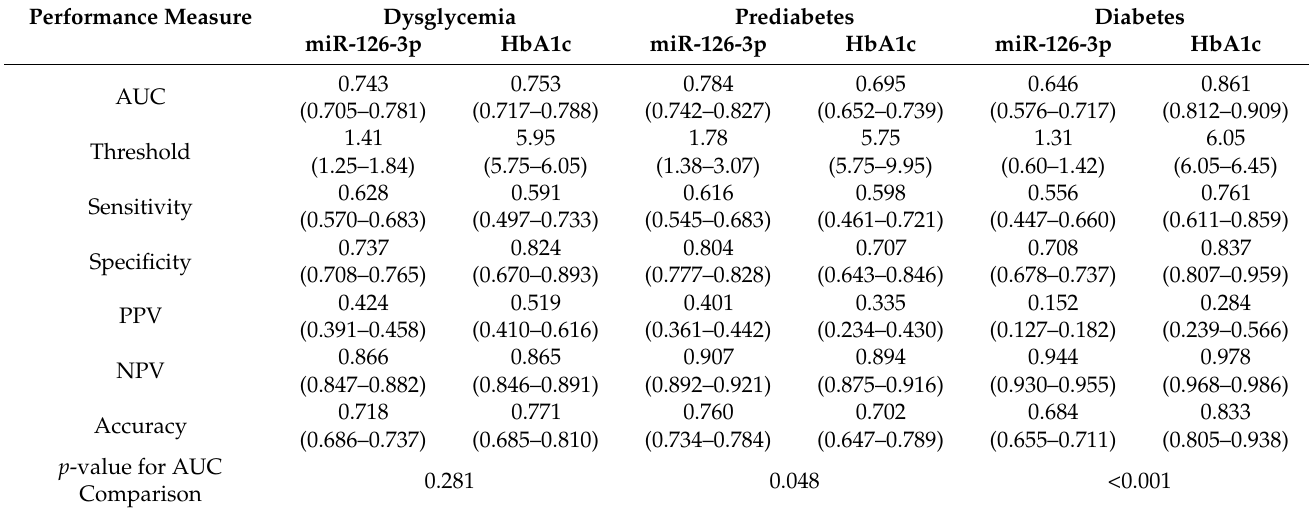
0.281 0.048 <0.001 AUC, area under the receiver operating characteristic curve; PPV, positive predictive value; NPV, negative predictive